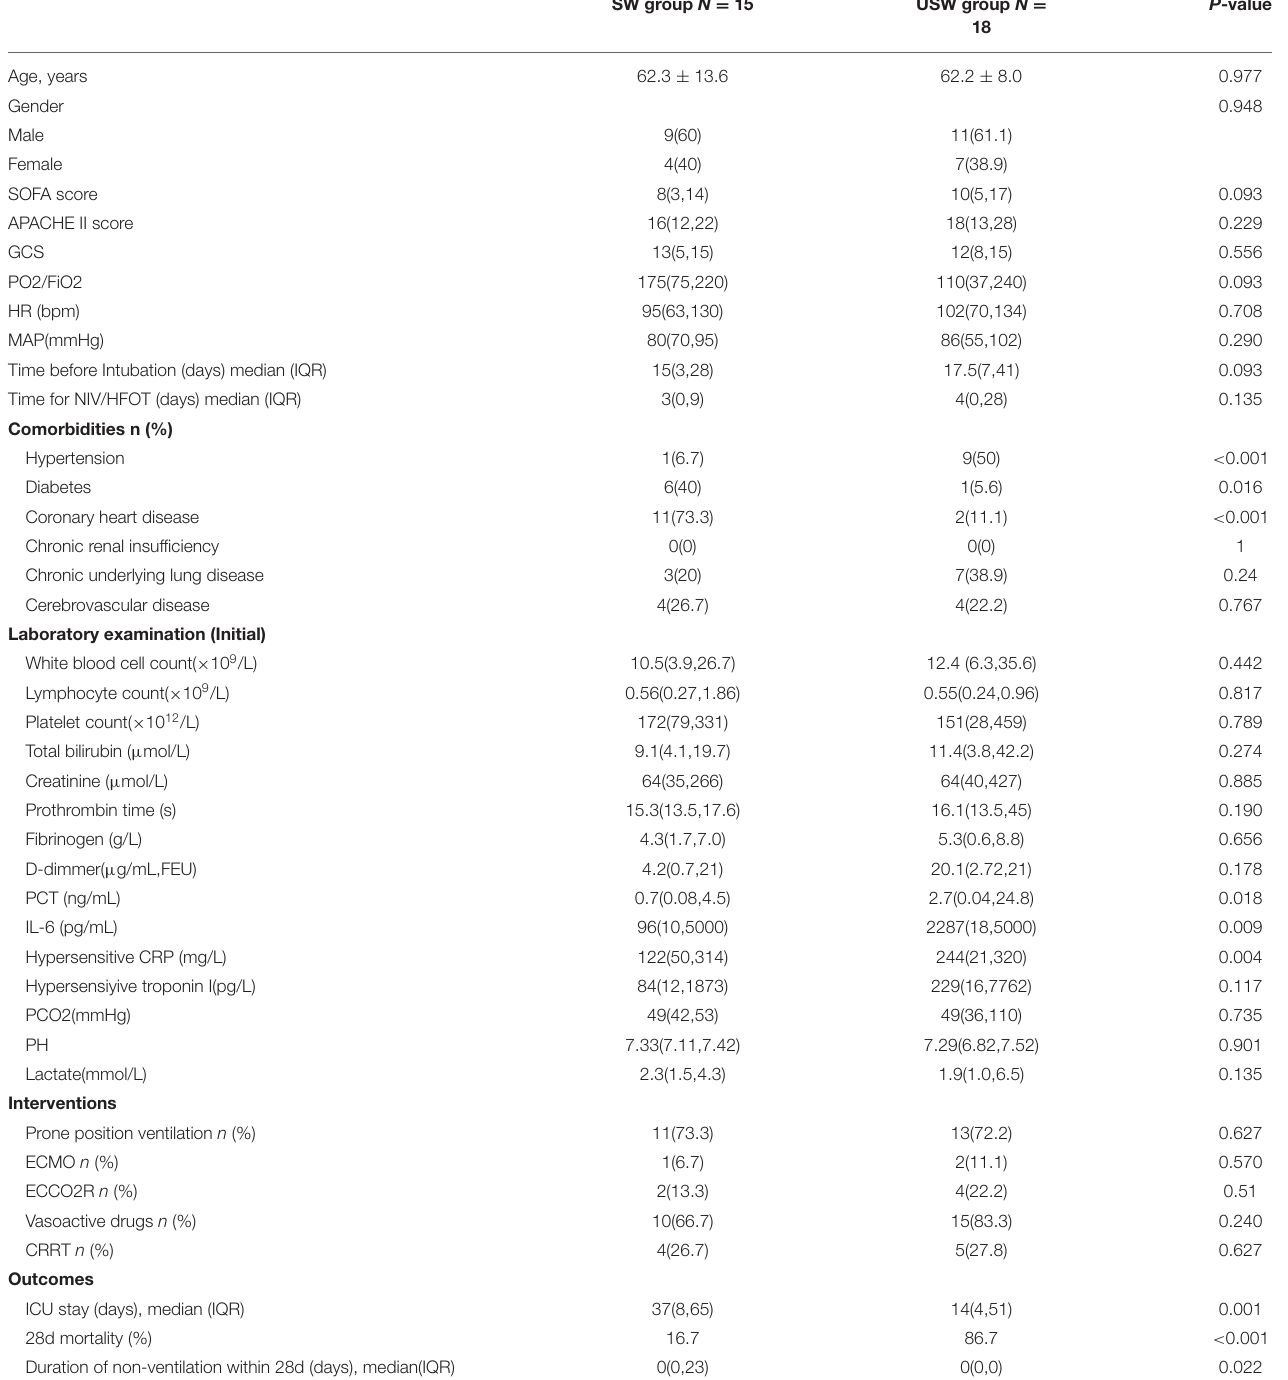
TABLE 1 | The Baseline characteristics and outcomes of the SW group vs. USW